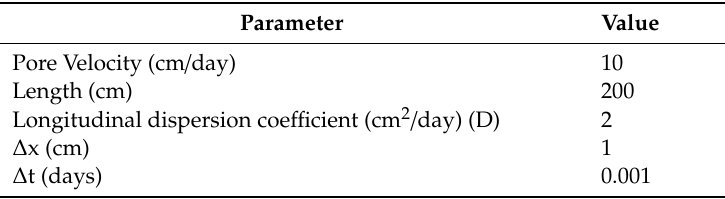
Table 5. Model parameters used for benchmark problem